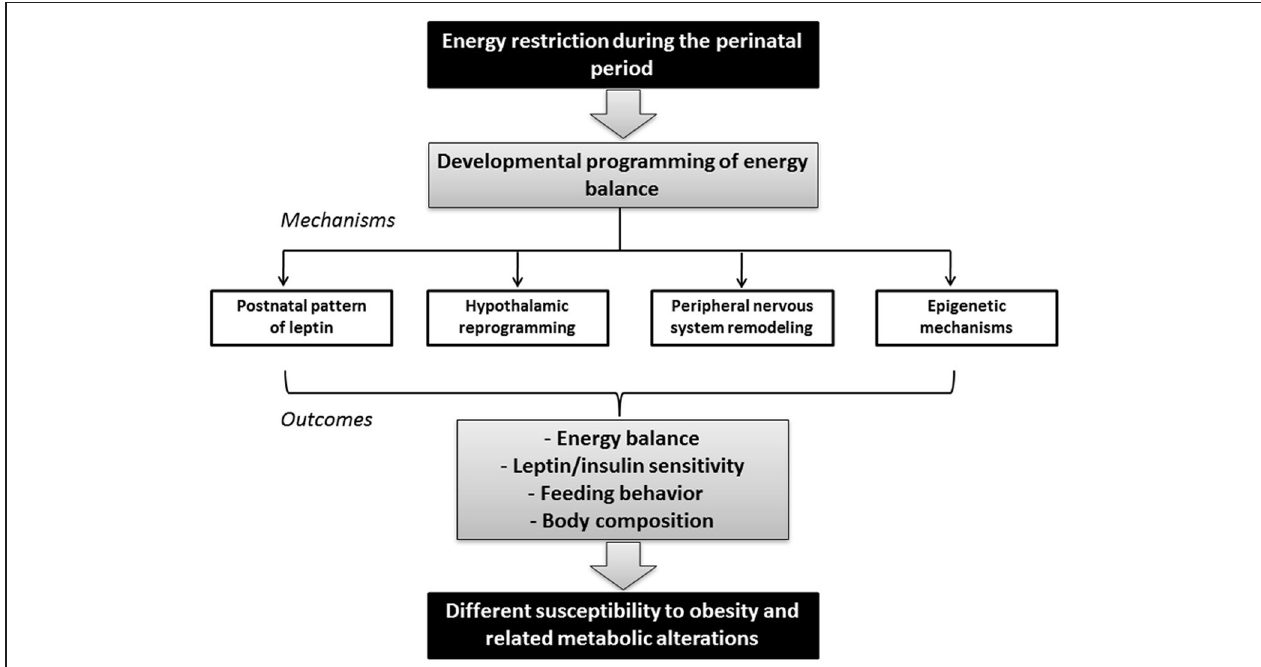
FIGURE 1 | Schematic diagram illustrating the link between maternal nutrition during the perinatal period and adult metabolic health. Energy restriction during gestation and/or lactation may impact the developmental programming of energy balance in the offspring, depending on factors such as the type, duration, period, and severity of conditions. Mechanisms underlying these effects may include changes in the postnatal pattern of